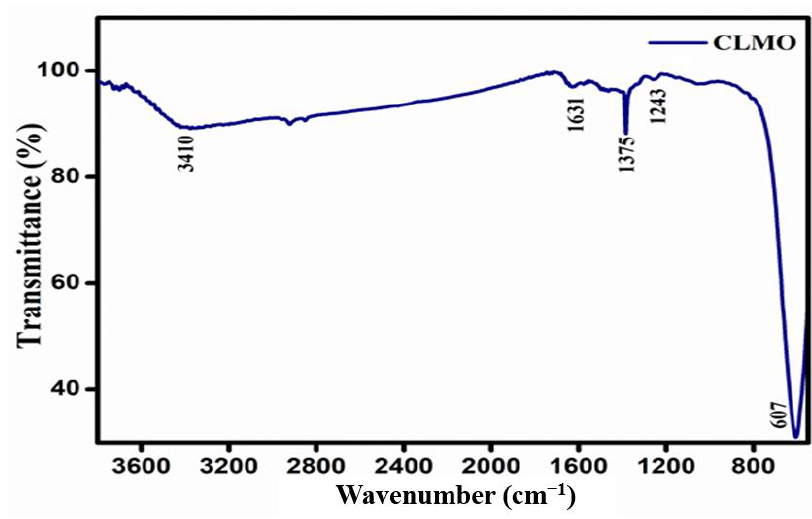
Figure 2. FTIR spectra of Ce 0.1 La 0.9 MnO 3 (CLMO) photocatalyst.